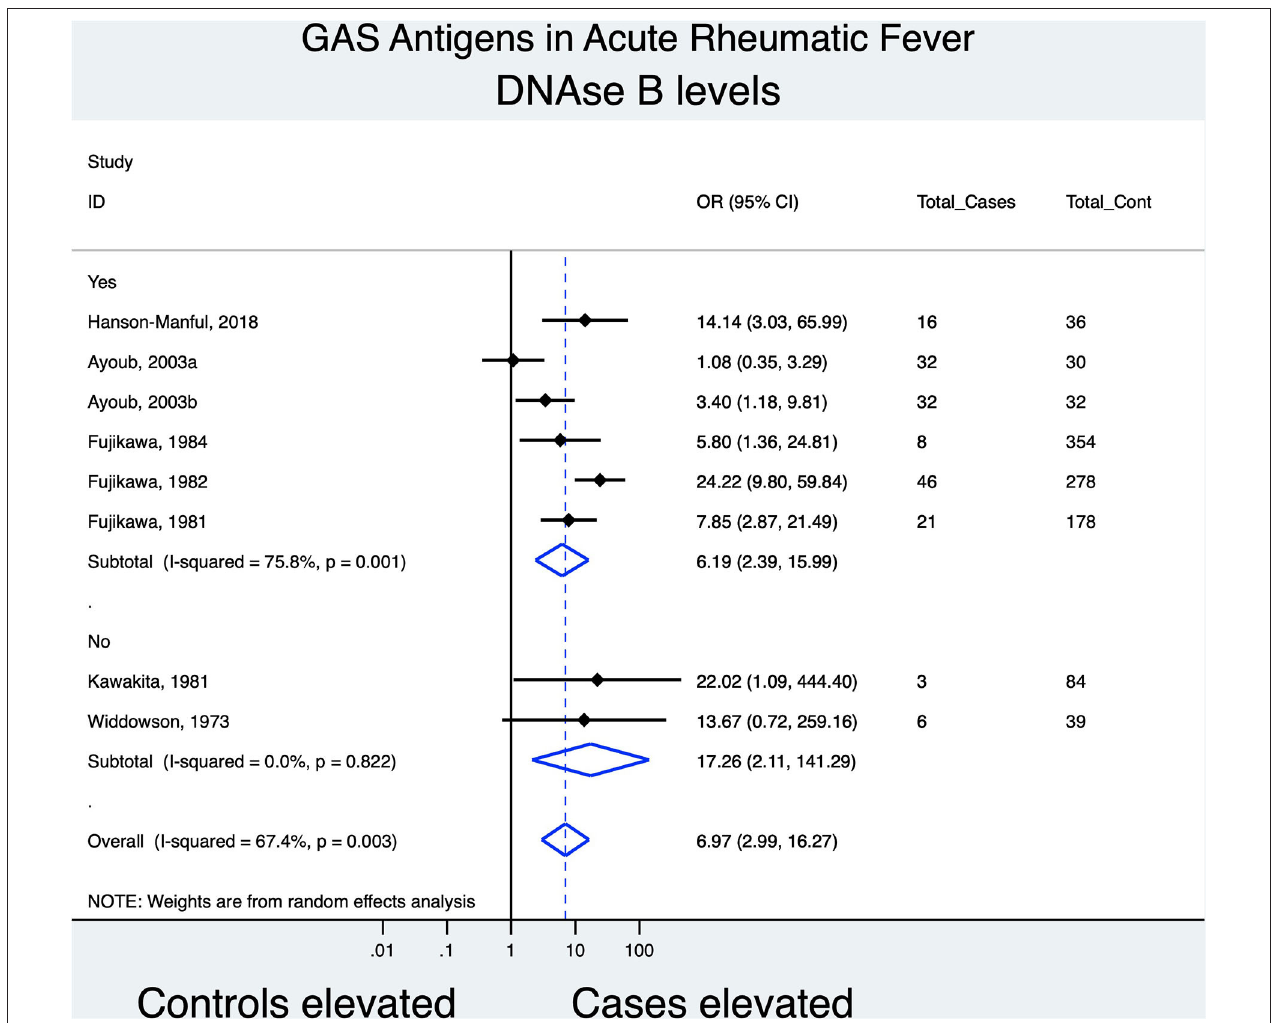
FIGURE 3 | Forest plot evaluating the odds of association between anti-DNase B titers and ARF; subgrouping based on whether a guideline was used to diagnose ARF